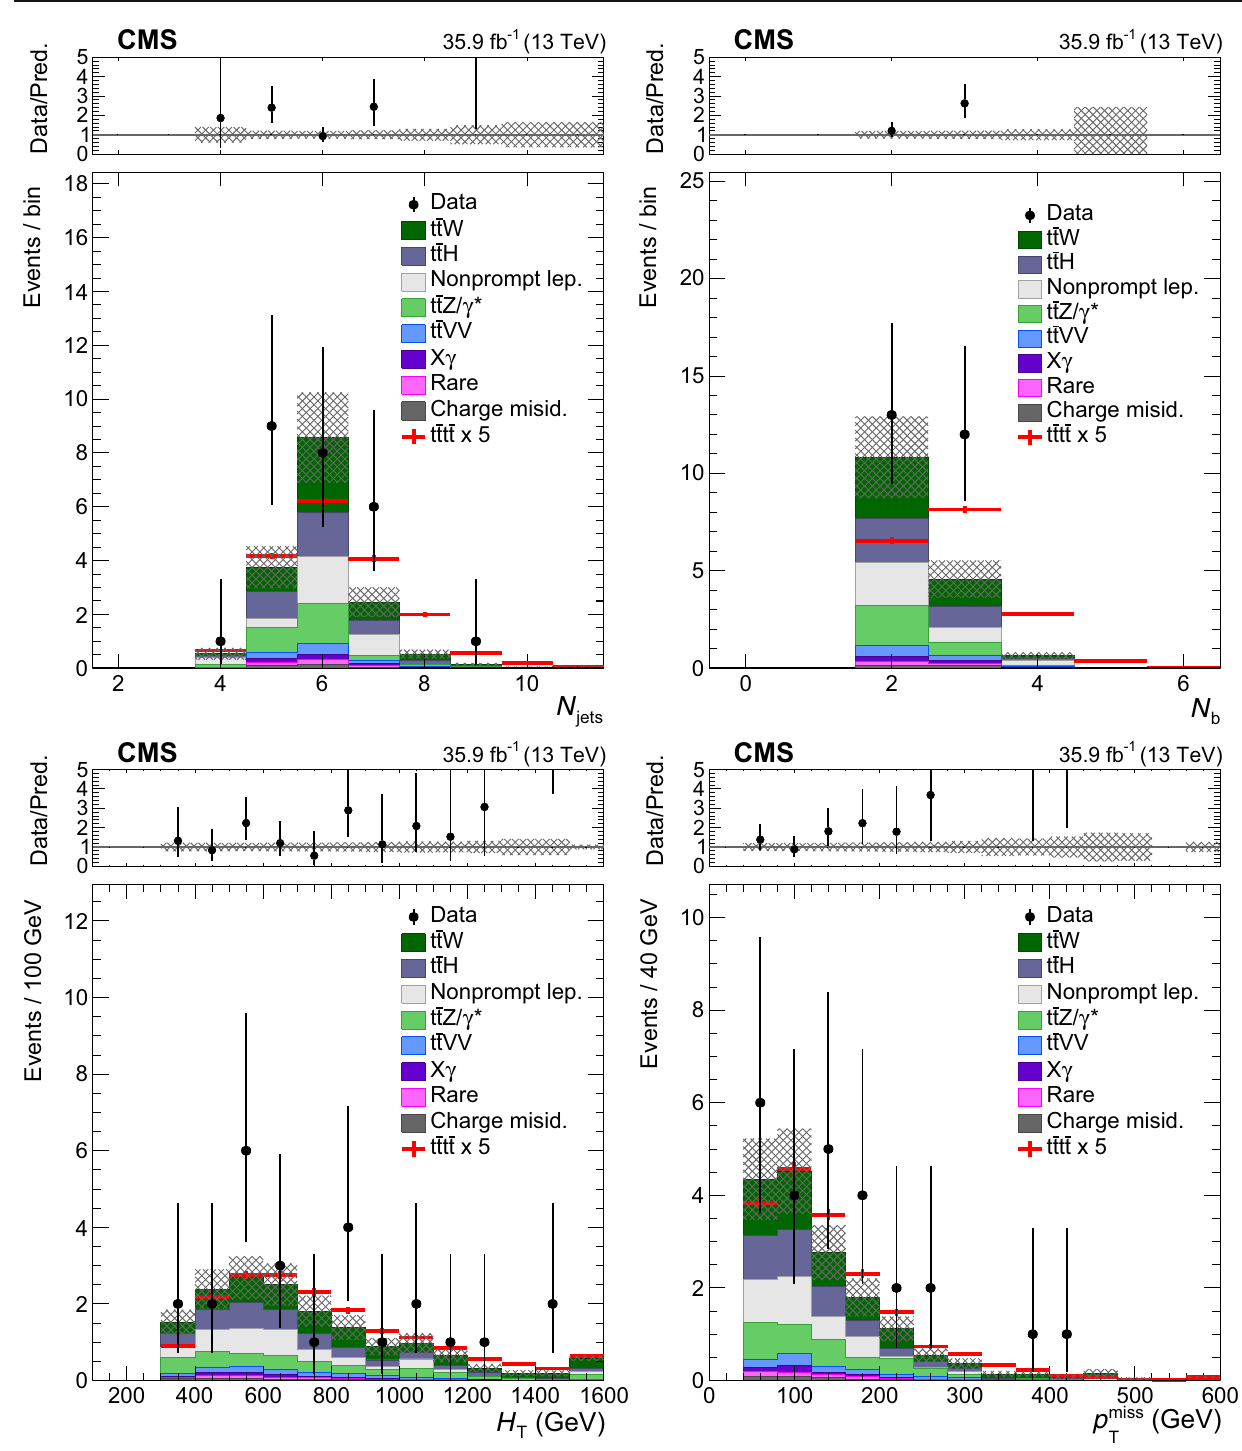
Fig. 2 Distributions in N jets (upper left), N b (upper right), H T (lower